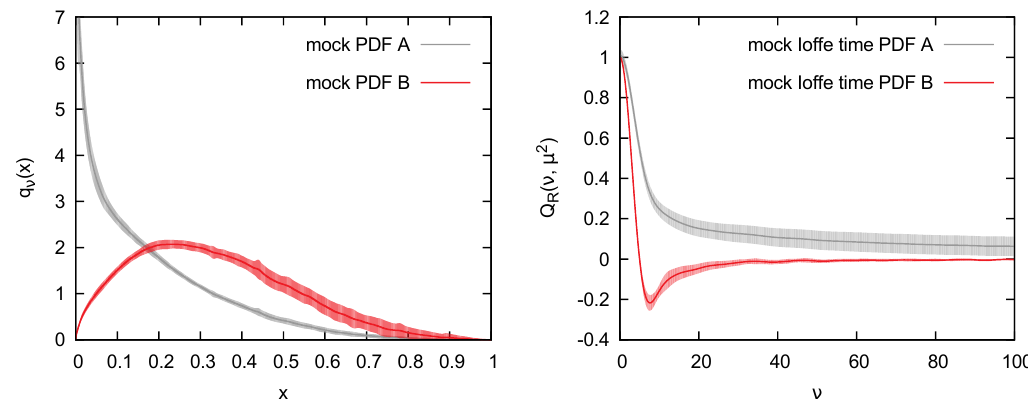
Figure 4 . The two mock datasets used for testing the methods. The PDF on the left. The Io(cid:11)e time PDF on the right. Scenario A (red band) will test the case of a PDF which diverges at small x and scenario B (blue band) will test the case of a PDF which converges at small x